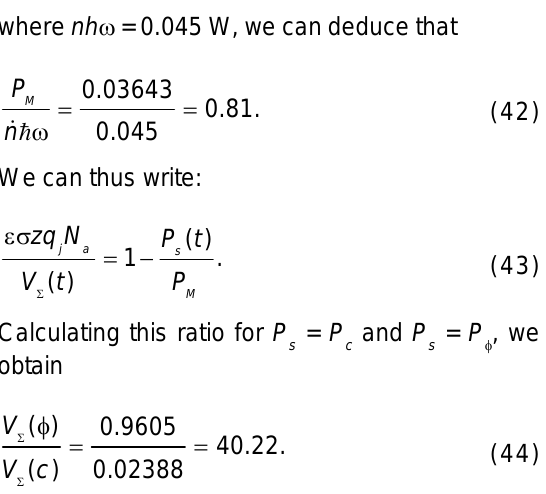
Fig. 9. Pulse repetition rate (solid triangle) and pulse width (empty square) as a function of  , the dis- tance between the chamber middle plane and the lenses’ common focus. Figure taken from the work of Chiu et al.